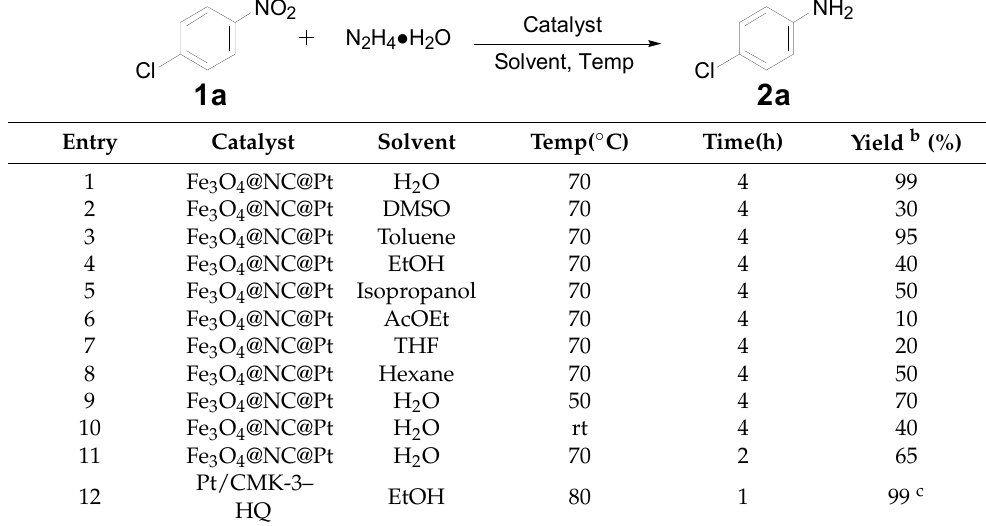
Table 2. Optimization of reaction conditions a .